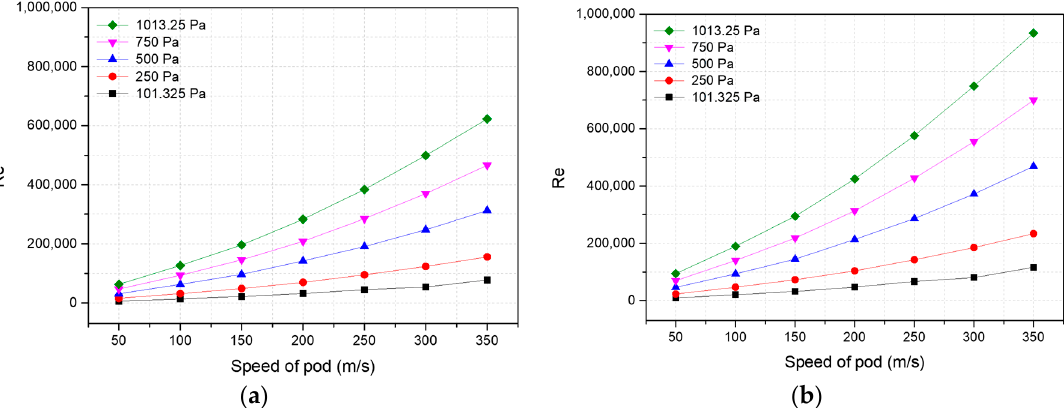
Figure 1. Variation of Re on the blockage ratio (BR), tube pressure, and pod velocity; ( a ) BR: 0.36, and ( b ) BR: 0.25.